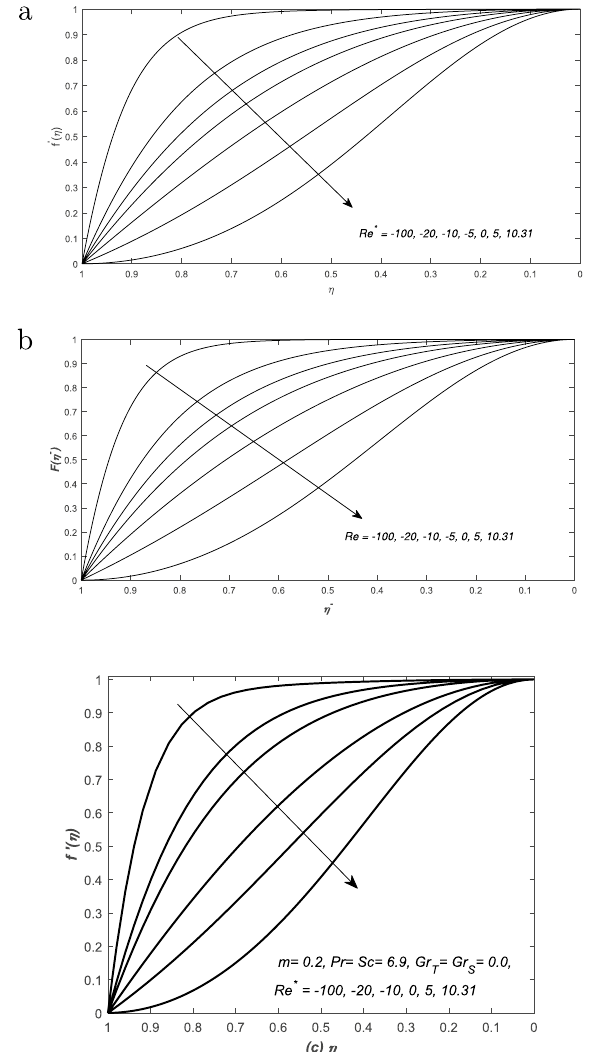
Figure 6. The axial velocity f ′ (η) is plotted against the similarity variable η for different values of modified Reynolds number Re ∗ = mRe and the results are compared with published work of ( a ) Laila et al. 25 and ( b ) Marwat et al. 26 . The profiles in ( c ) showed that curves of f ′ (η) are exactly matched with these two published papers. Note that the profiles in ( a ) and ( b ) are published in the Fig. 4 and 16 of R. Laila et al. 25 and Marwat et al. 26 ,